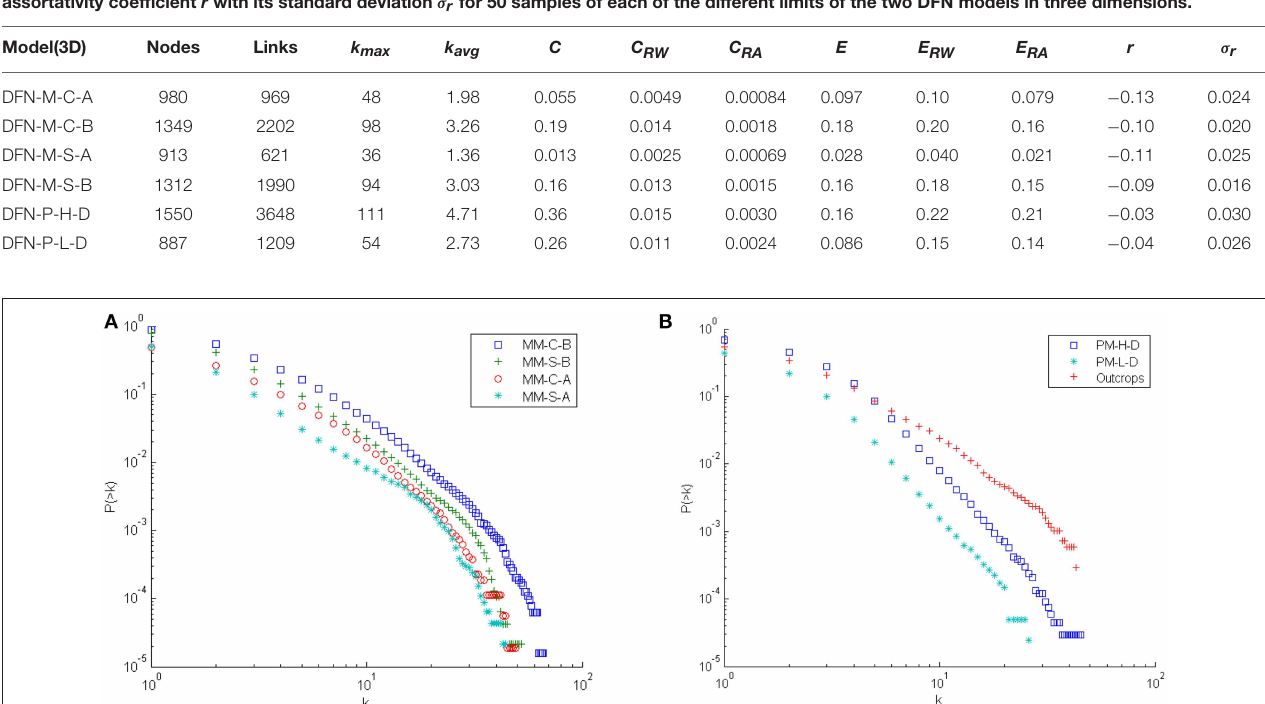
TABLE 2 | Averaged values of the number of nodes, links, maximum degree k max , average degree k avg , clustering coefficient C , clustering coefficient for rewired graphs C